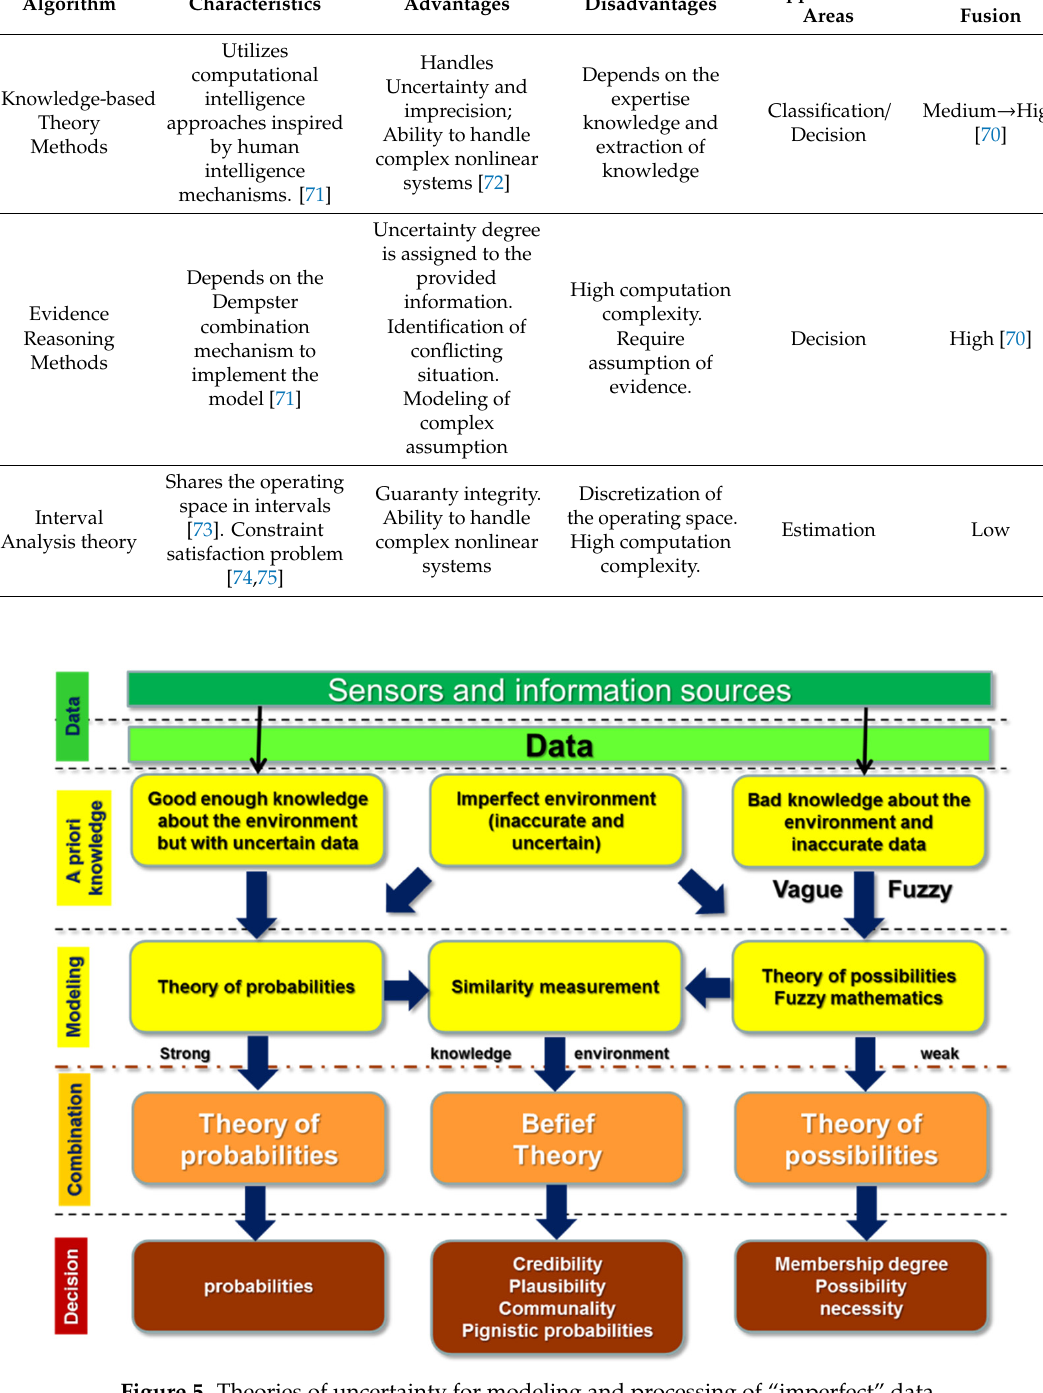
Figure 5. Theories of uncertainty for modeling and processing of “imperfect” data.